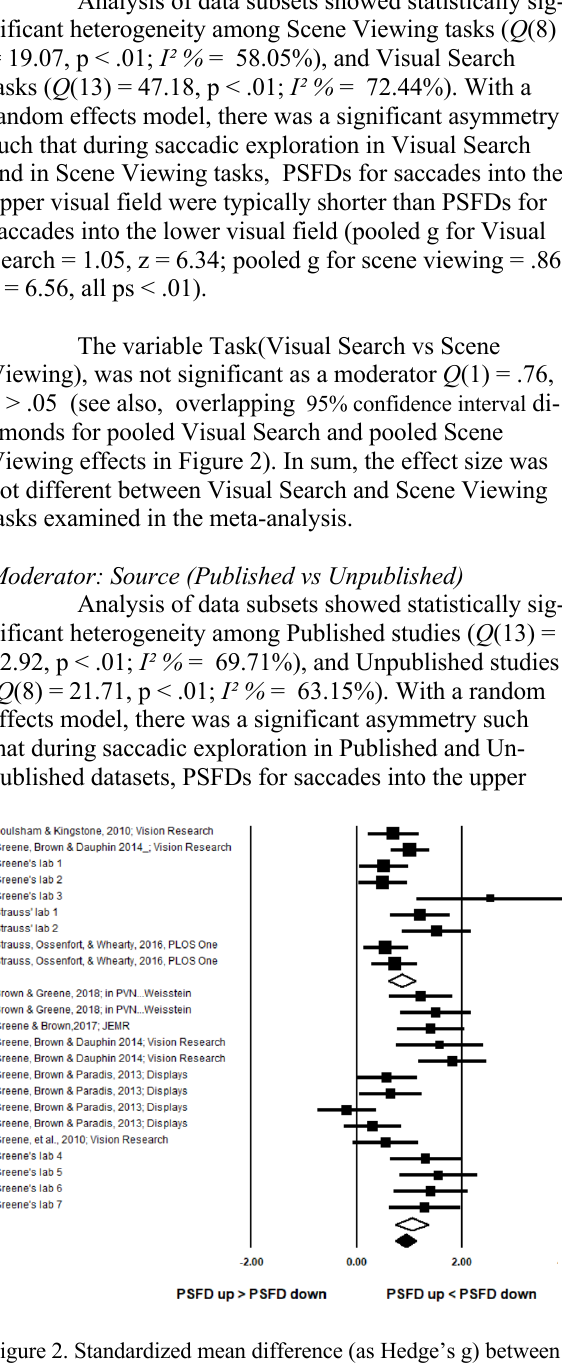
Figure 2. Standardized mean difference (as Hedge’s g) between PSFDs for up-directed and down-directed saccades. The se- quence of datasets in the forest plot is the same as the sequence presented in Table 1. Error bars represent 95% confidence in- tervals. The sizes of the black squares reflect sample sizes. Pooled effect sizes are shown as diamonds for scene